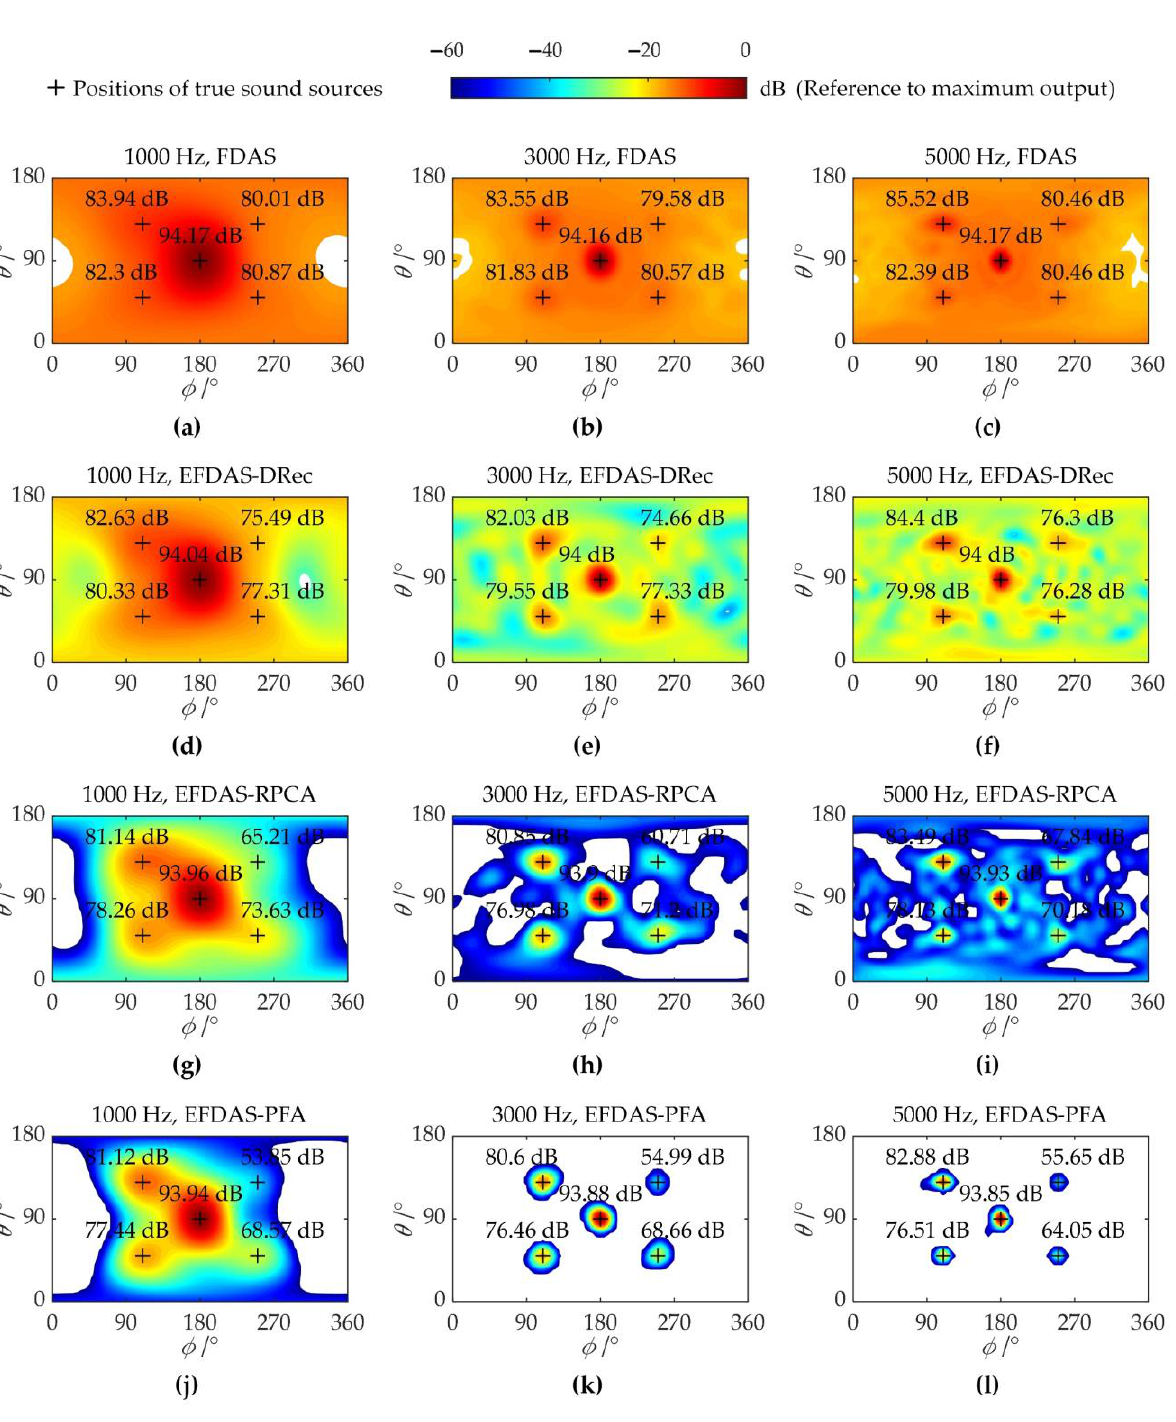
Figure 9. Colormaps of FDAS and EFDAS with SNR = 0 dB and 1000 snapshots: ( a – c ) Maps of FDAS at 1000 Hz, 3000 Hz, and 5000 Hz, respectively; ( d – f ) Maps of EFDAS-DRec at 1000 Hz, 3000 Hz, and 5000 Hz, respectively; ( g – i ) Maps of EFDAS-RPCA at 1000 Hz, 3000 Hz, and 5000 Hz, respectively; ( j – l ) Maps of EFDAS-PFA at 1000 Hz, 3000 Hz, and 5000 Hz, respectively. EFDAS-DRec, EFDAS-RPCA, and EFDAS-PFA all improve the sound source identi-